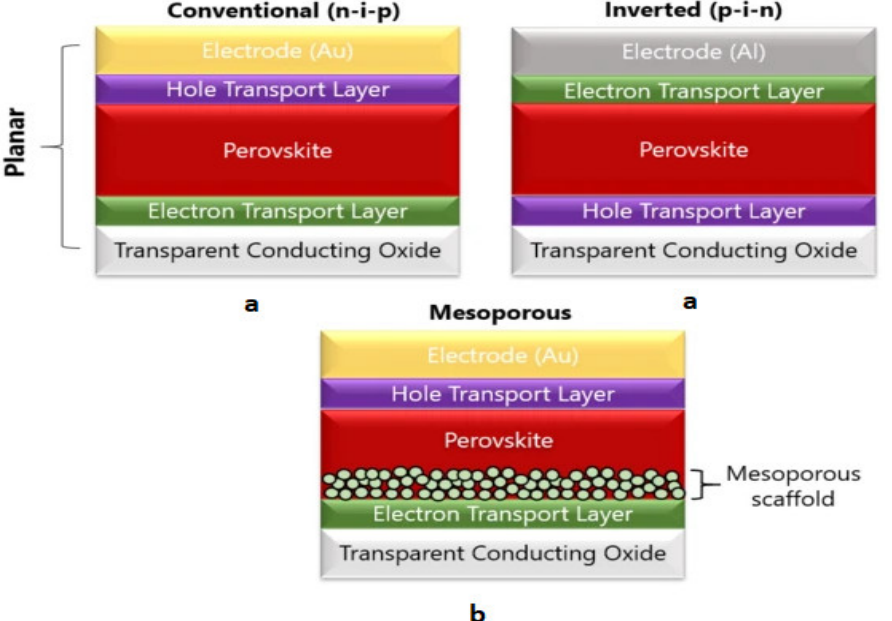
Figure 1. Schematic representation of different PSC configurations [18]. ( a ) planar and ( b ) mesoporous